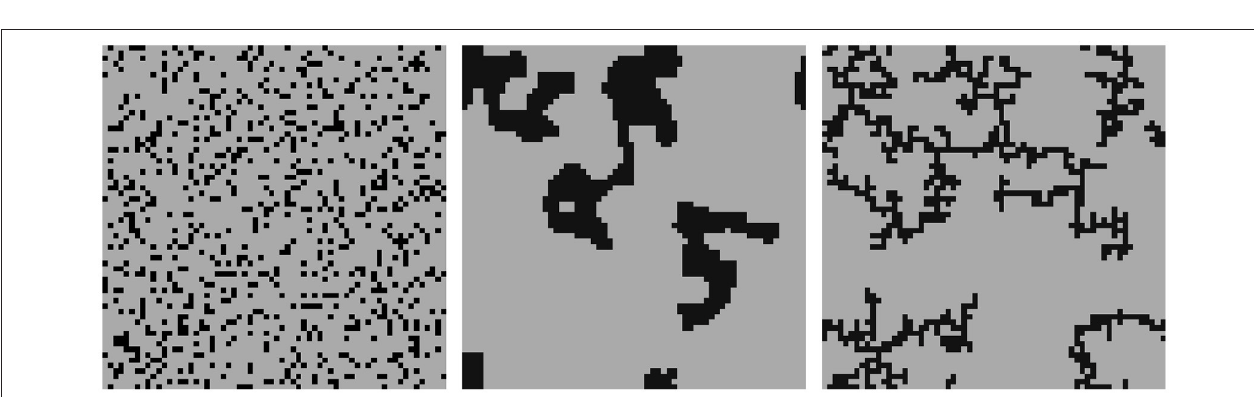
FIGURE 9 | Effects of charges in solid restructuring: Initial configuration for both simulations, porosity θ = 0.8 (left) , quasi stationary configuration without charges (middle) , and quasi stationary configuration with randomly distributed charges dominating the restructuring (right)